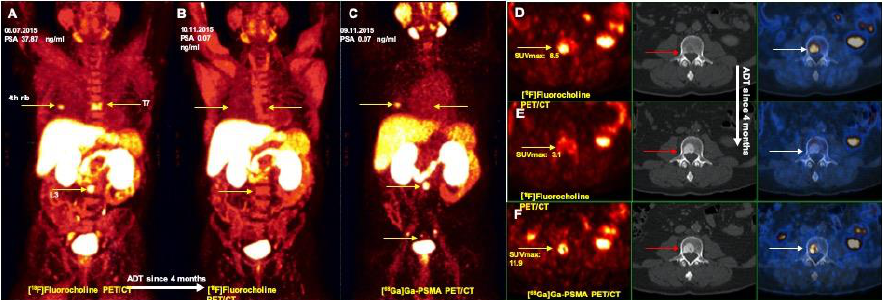
Figure 4. Prostate cancer treatment monitoring: more accurate evaluation of the treatment by [ 68 Ga]Ga-PSMA PET/CT. ( A ) [ 18 F]Fluorocholine PET: MIP revealed multiple bone metastases (arrows) on 4th right rib, T7 and L3 vertebra corresponding with morphological changes on CT. ( B ) Treatment monitoring by [ 18 F]Fluorocholine PET: MIP showed no abnormal tracer uptake in the known metastases (arrows), suggestive complete response well correlating with PSA value of 0.07 ng/mL. ( C ) Treatment monitoring by [ 68 Ga]Ga-PSMA PET MIP revealed still metabolic activity on the 4th right rib, and L3 vertebra (arrows) showing clear superiority to [ 18 F]Fluorocholine PET and clinical findings. ( D ) transaxial views: PET (left), CT (middle) and fusion PET/CT (right) images. ( E ) transaxial views; PET (left), CT (middle) and fusion PET/CT (right) images. ( F ) transaxial views: PET (left), CT (middle) and fusion PET/CT (right) images.